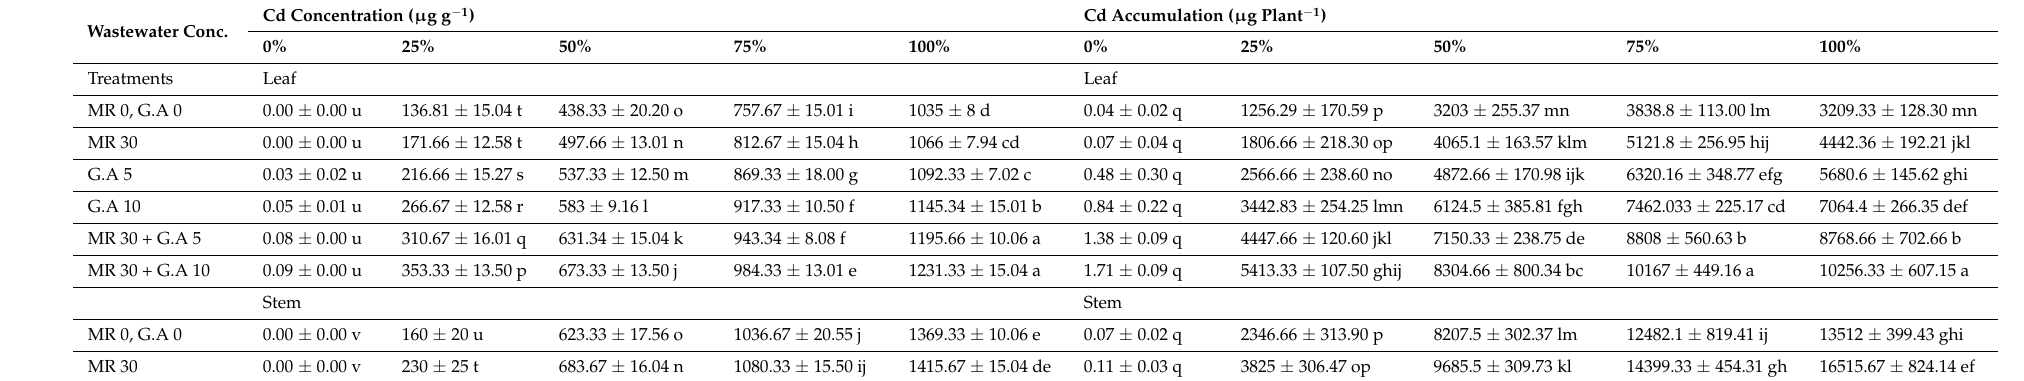
Figure 4. Surgical and textile effluent and glutamic acid effect on APX in roots ( A ), APX in leaves ( B ), CAT in roots ( C ), CAT in leaves ( D ), POD in roots ( E ), POD in leaves ( F ), SOD in roots ( G ), and SOD in leaves ( H ) in Sorghum L. Values are demonstrated as means of three replicates along with standard deviation. Different small letters indicate that values are significantly different at p < 0.05. Table 1 . Effect of surgical and textile effluent alone and/or in combination with GA on heavy metals uptake (µg g − 1 ) and accumulation (µg plant − 1 ) in microwave-treated and -untreated sorghum.